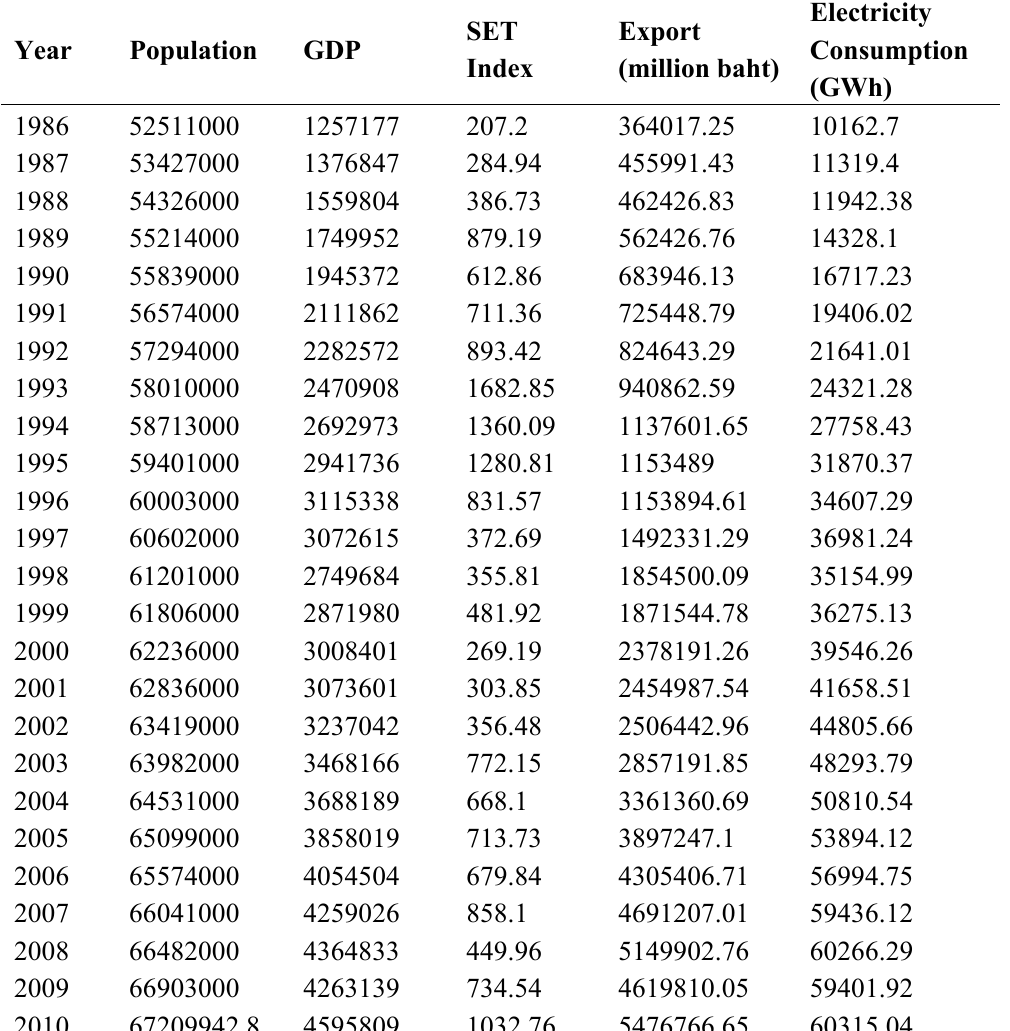
Table 1. Energy Data of Thailand from 1986 to